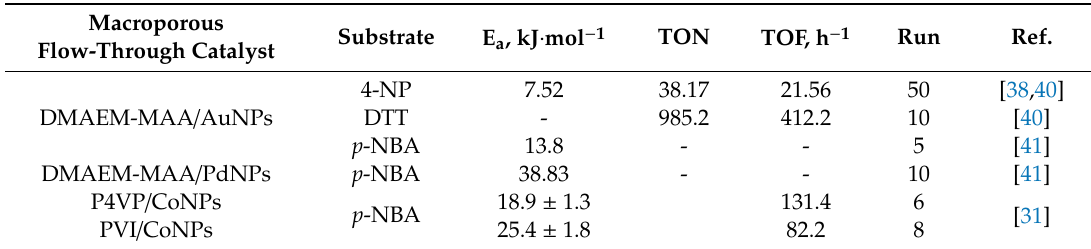
Table 2. Kinetic parameters of hydrogenation of nitroaromatic compounds and oxidation of DTT over macroporous flow-through catalytic